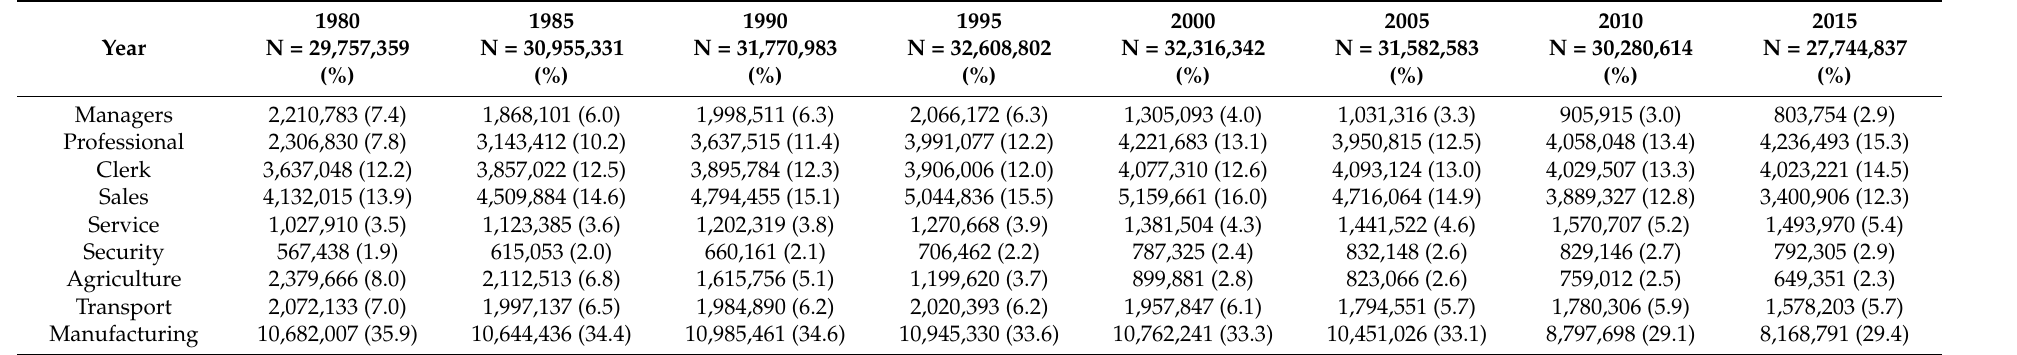
Table 1. Proportion of population among Japanese men of working age by occupation from 1980 to